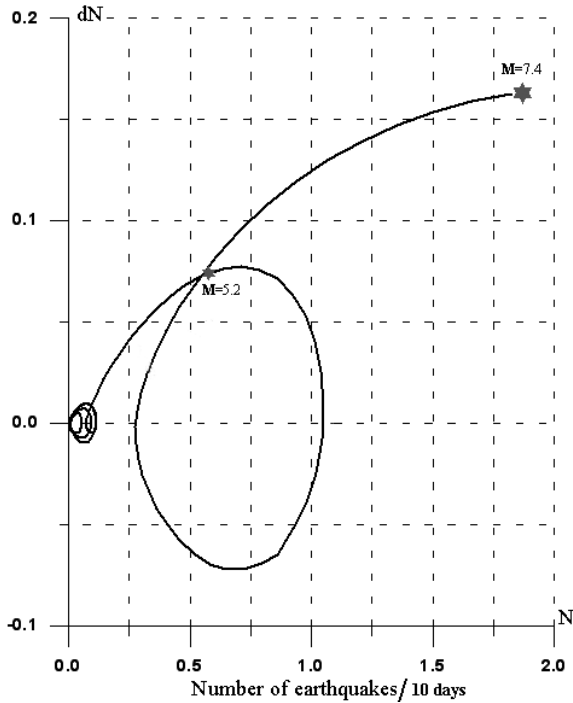
Fig. 11. Phase portrait of seismicity within a radius of 100km from the epicenter of the Haicheng earthquake for a 5-year period (1 January 1970–4 February 1975). The smoothed number N of earthquakes for 10 consecutive days is marked on the X axis. Rates at which these parameters change, i.e. the difference between the following and the preceding values are shown on the Y axis. The clockwise movement along the curve corresponds to an increase in time. The stars mark the position of the main shock ( M = 7 . 4) and foreshock ( M = 5 .